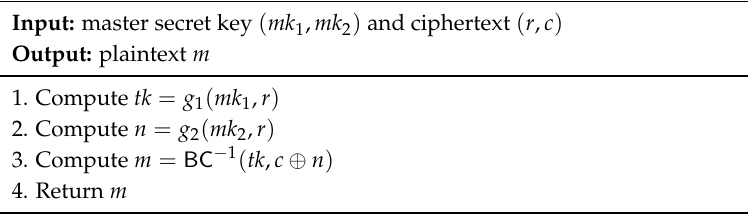
Algorithm 4 First-order SCA-resistant re-keying encryption scheme: dec